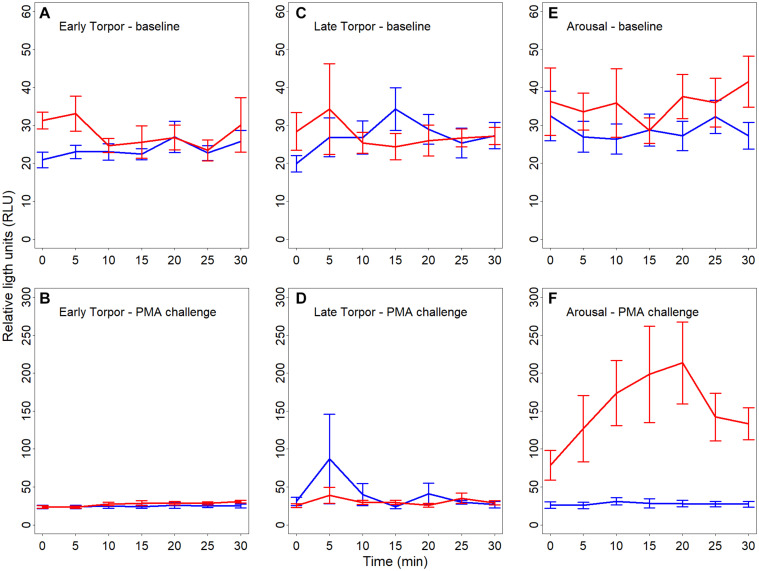
(A–F) Line plots showing baseline reactive oxygen species (ROS; A,C,E) as well as challenge ROS levels (B,F,F) in full blood of hibernating garden dormice measured for 30 s every 5 min over 30 min and expressed in relative light units (“RLU”). Chemiluminescence was measured in different physiological states within the torpor-arousal cycle, i.e., in early torpor (A,B; n = 8), late-torpor (C,D; n = 9), and interbout arousal (E,F; n = 8) at both 6°C (blue lines) and 35°C (red lines). There was no significant difference in baseline chemiluminescence between the different states (all p > 0.5) with a small increase in baseline ROS in IBA animals when measured at 35°C. Error bars represent the standard error.